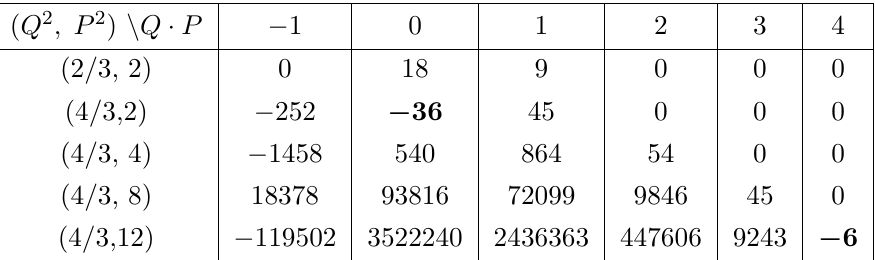
Table 21 . Some results for the index (cid:0) B 6 for the torus order 3 orbifold of T 4 for di(cid:11)erent values of Q 2 , P 2 and Q (cid:1) P